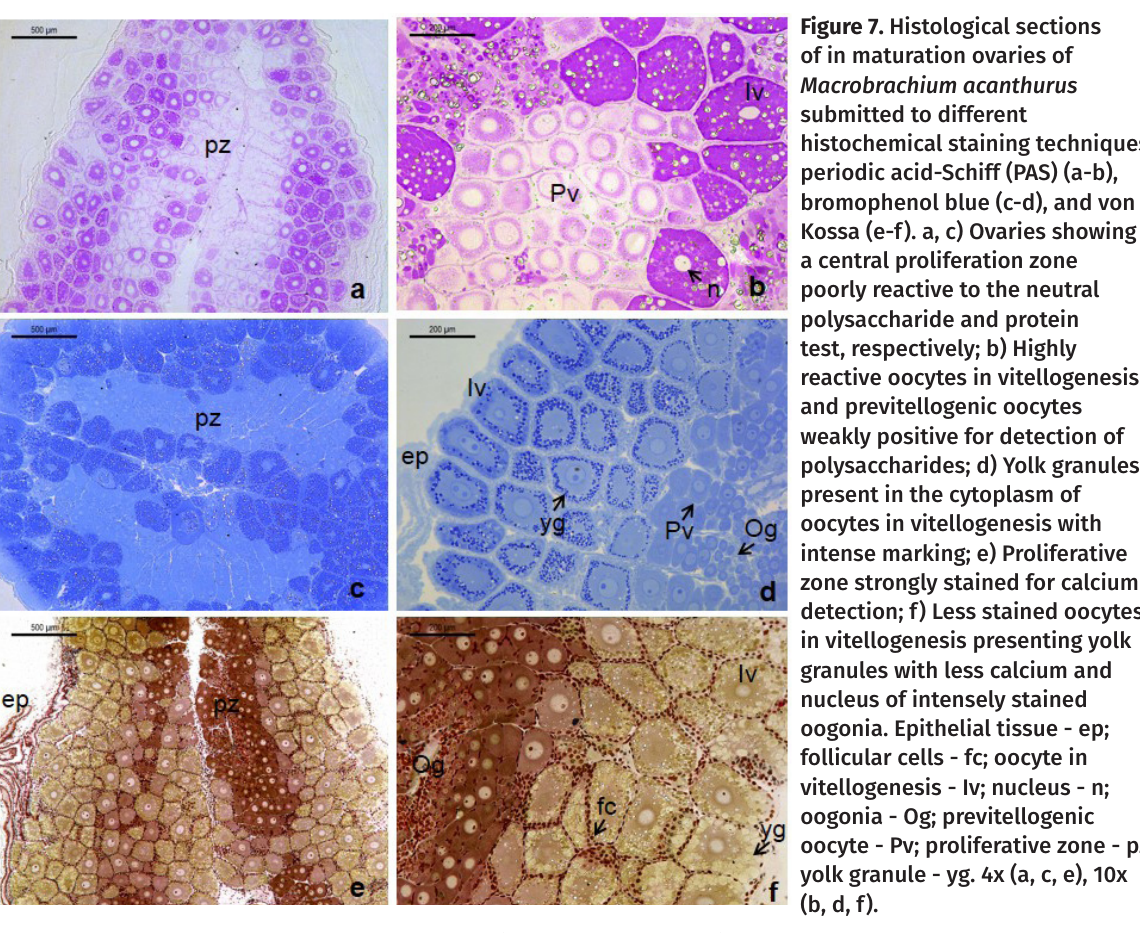
Table III. Histochemical analysis of the germ cells (oogonia and oocytes) of Macrobrachium acanthurus.